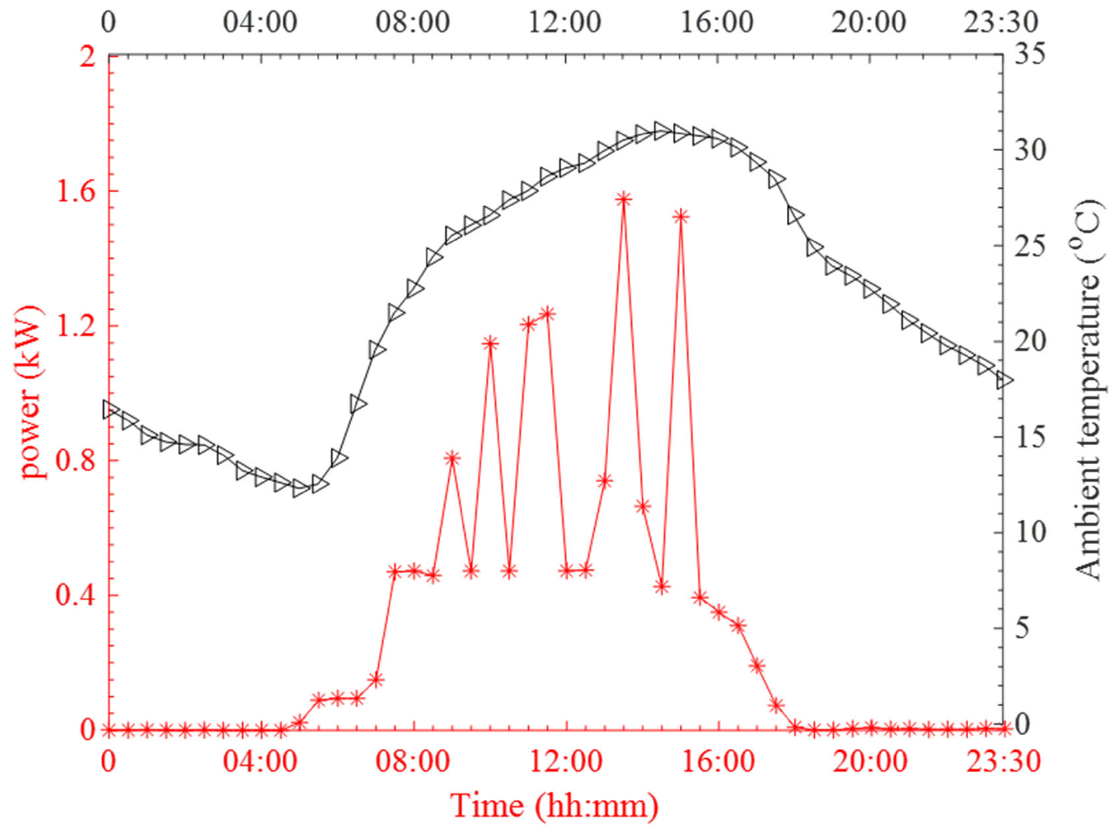
Figure 8. Typical day profiles of power consumed and ambient temperature. (kW denotes kilo Watts and ◦ C represents degree Celsius, hh denotes hour and mm denotes minute).